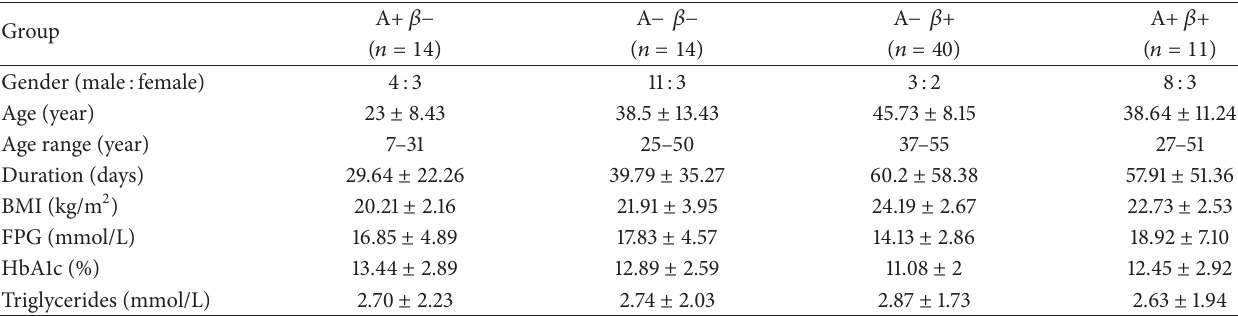
Table 1: Ketosis-onset diabetes clinical feature.